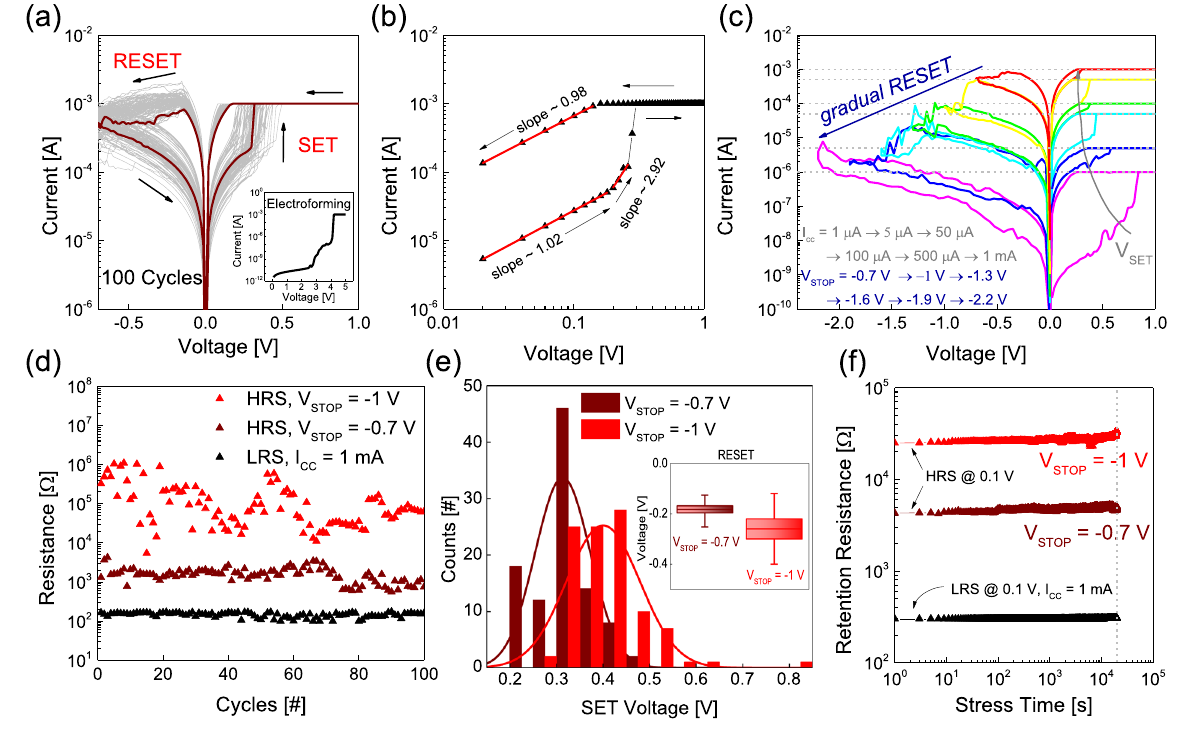
Figure 2. An a-SVO-based memristor exhibiting bipolar resistive switching. ( a ) I-V properties of the Ag/a- SVO/Pt memristor after 100 consecutive DC cycles. The inset graph represents the electroforming process. ( b ) DC I-V properties with a positive bias and the corresponding slopes on a double-logarithmic scale. ( c ) I CC -modulated DC I-V curves with a positive bias and stop voltage-modulated DC I-V curves with a negative bias. The arrow denotes the sweep sequence. (d ) Endurance testing up to 100 cycles at an LRS with an I CC of 1 mA and at HRSs with V STOP = − 0.7 and − 1 V. ( e ) The distribution of the SET voltage. The inset indicates the distribution of the RESET voltage. ( f ) Retention testing up to 2 × 10 4 s at an LRS with an I CC of 1 mA, and at HRSs with V STOP = − 0.7 and − 1